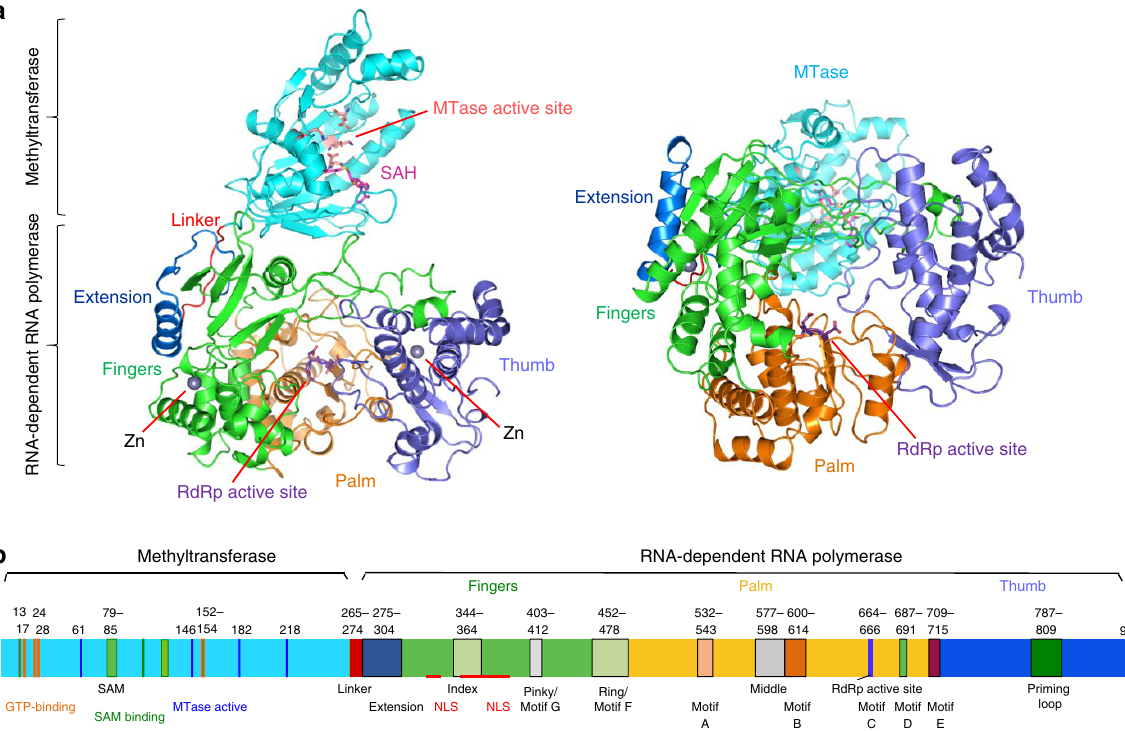
Figure 1 | Structure of full-length ZIKV NS5. ( a ) Ribbon representation showing the arrangement of the MT and the RdRp domains of ZIKV NS5.